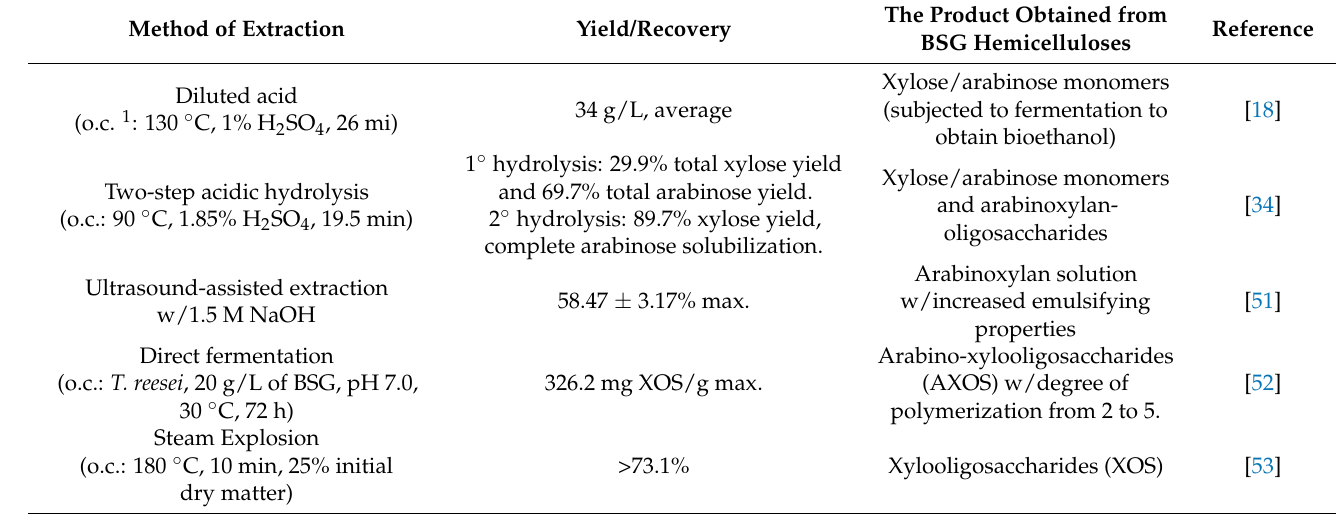
Table 3. Brewer’s spent grain hemicellulose extraction methods, yield, and the final product obtained. Method of